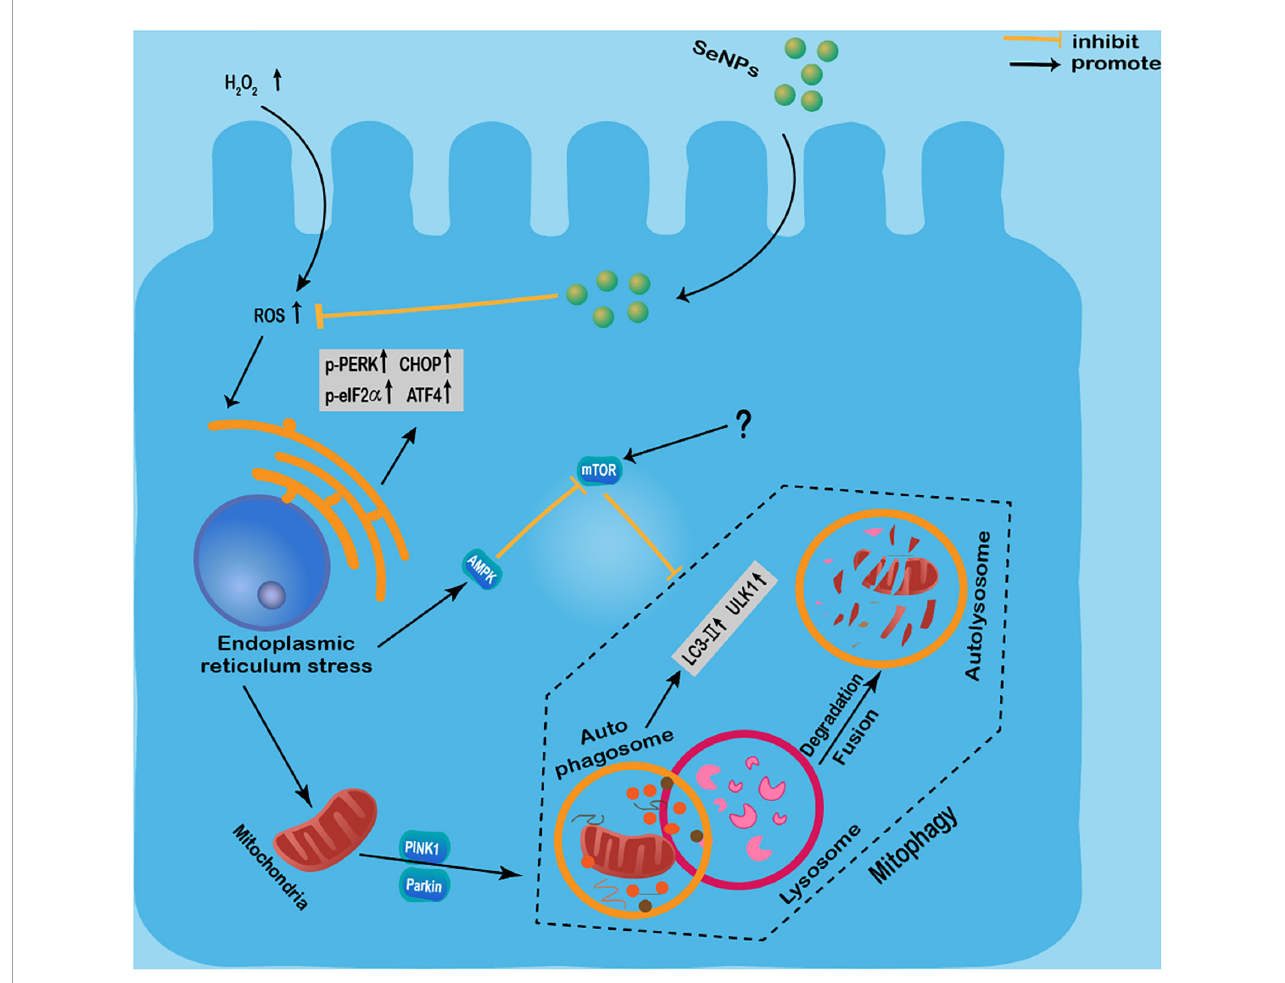
FIGURE3 Protective effects of selenium nanoparticles (Se NPs) regulated autophagy against H 2 O 2 -induced cell dysfunction by regulating mTOR/PINK1-mediated pathway, PERK/eIF2 α /ATF4 and AMPK/mTOR/PINK1 signaling pathway.